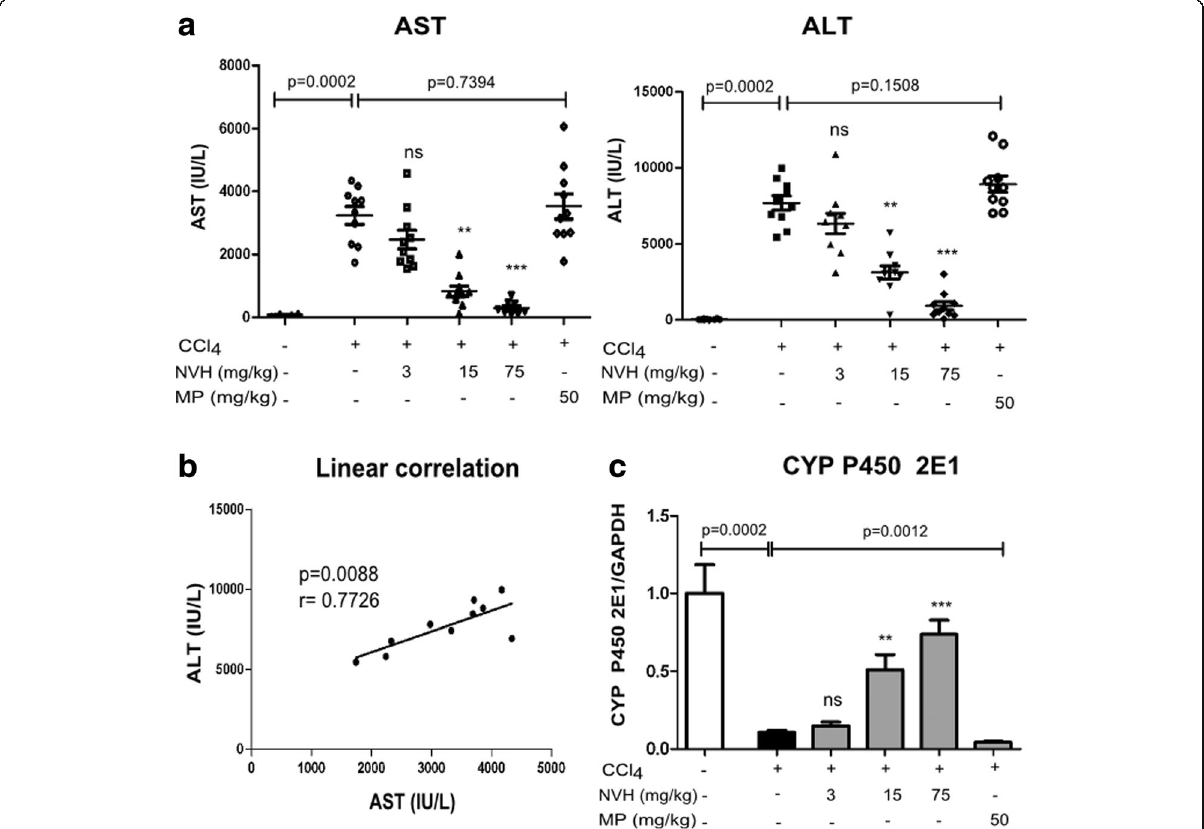
Fig. 6 Transaminases serum level and CYP 2E1 expression in CCl 4 -intoxicated mice. Animals were pretreated with NVH extract or methylprednisolone during 3 consecutive days. On the third day, acute liver injury was induced with CCl 4 . Mice were sacrificed 24 h after CCl 4 injection. a : Dot plot showing Aspartate aminotransferase (left panel) and Alanine aminotransferase (right panel) serum level for each animal in 6 different groups. b : Correlation between Aspartate aminotransferase and Alanine aminotransferase serum level. c : CYP 2E1 expression. Bar graphs represent CYP 2E1 expression. Medians are indicated by a horizontal line. Significant Dunn ’ s post tests are indicated as * p <0.05; ** p <0.01; *** p <0.001; ns: non- significant. The p -value indicates the Mann-Whitney test; experiment conducted once; n =10 in each group. AST: Aspartate aminotransferase; ALT: Alanine aminotransferase; NVH: Neoboutonia velutina aqueous extract; MP: Methylprednisolone; CCl 4 : Carbon